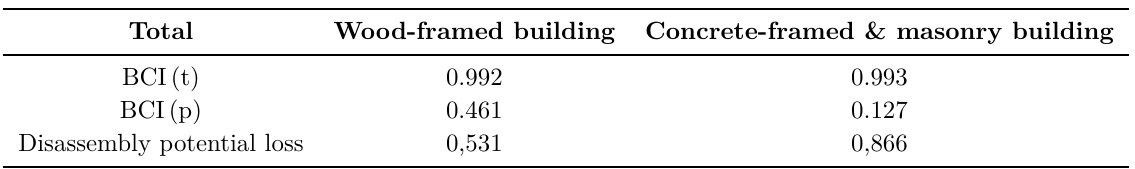
Table 2. BCI results for the cases